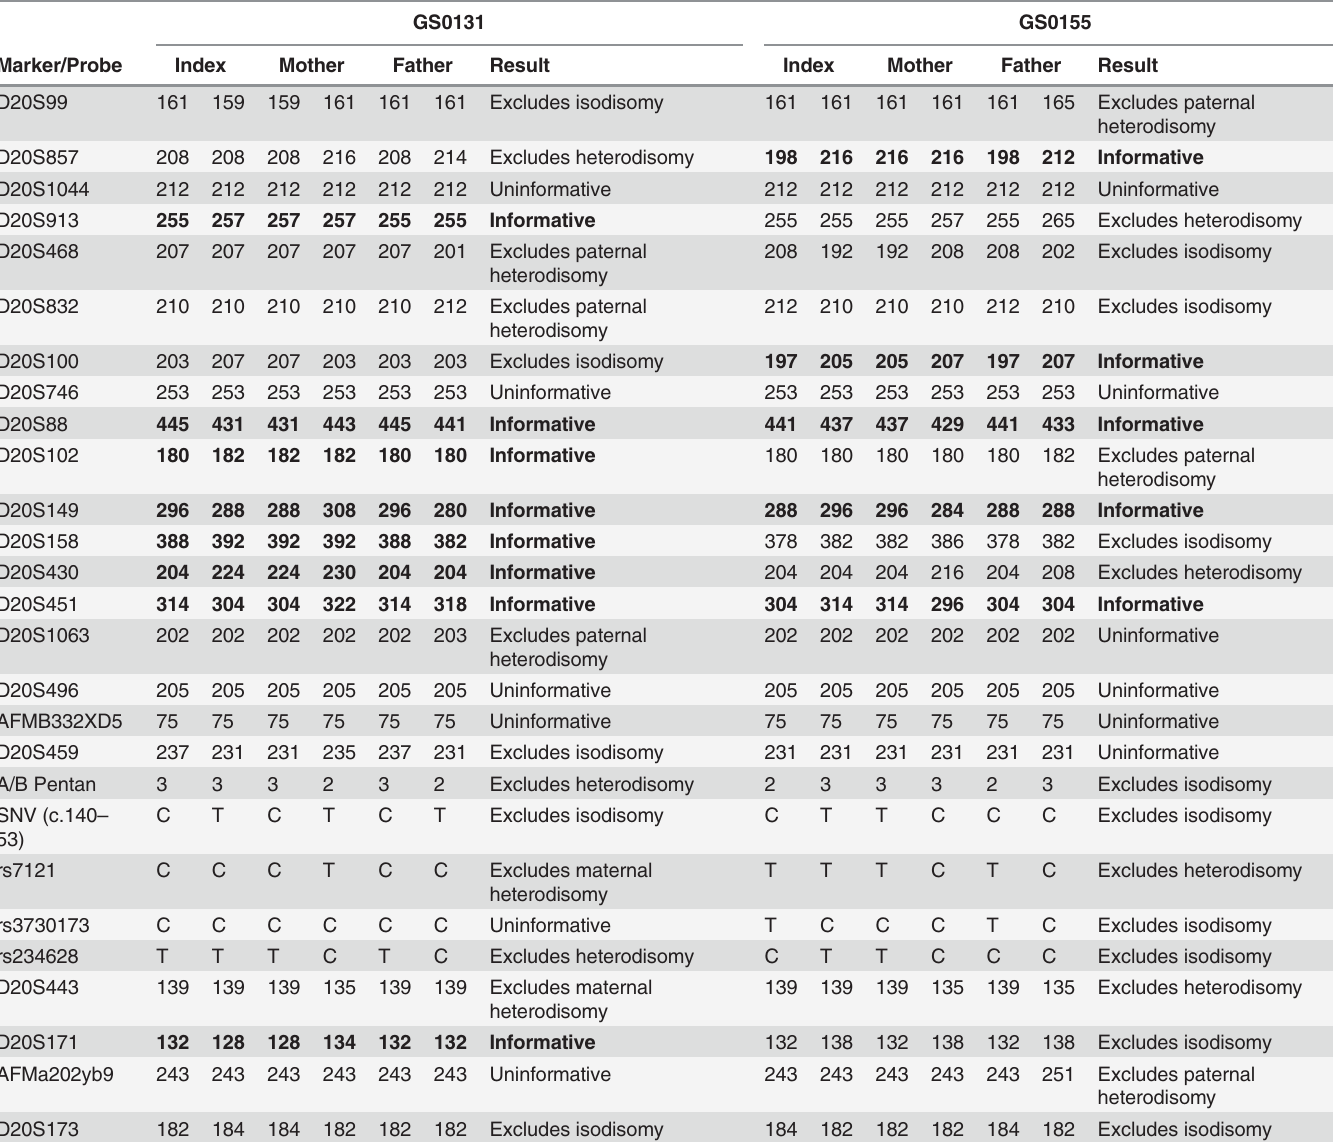
Table 2. Genotyping results of the 27 polymorphic markers at 20q in both families.